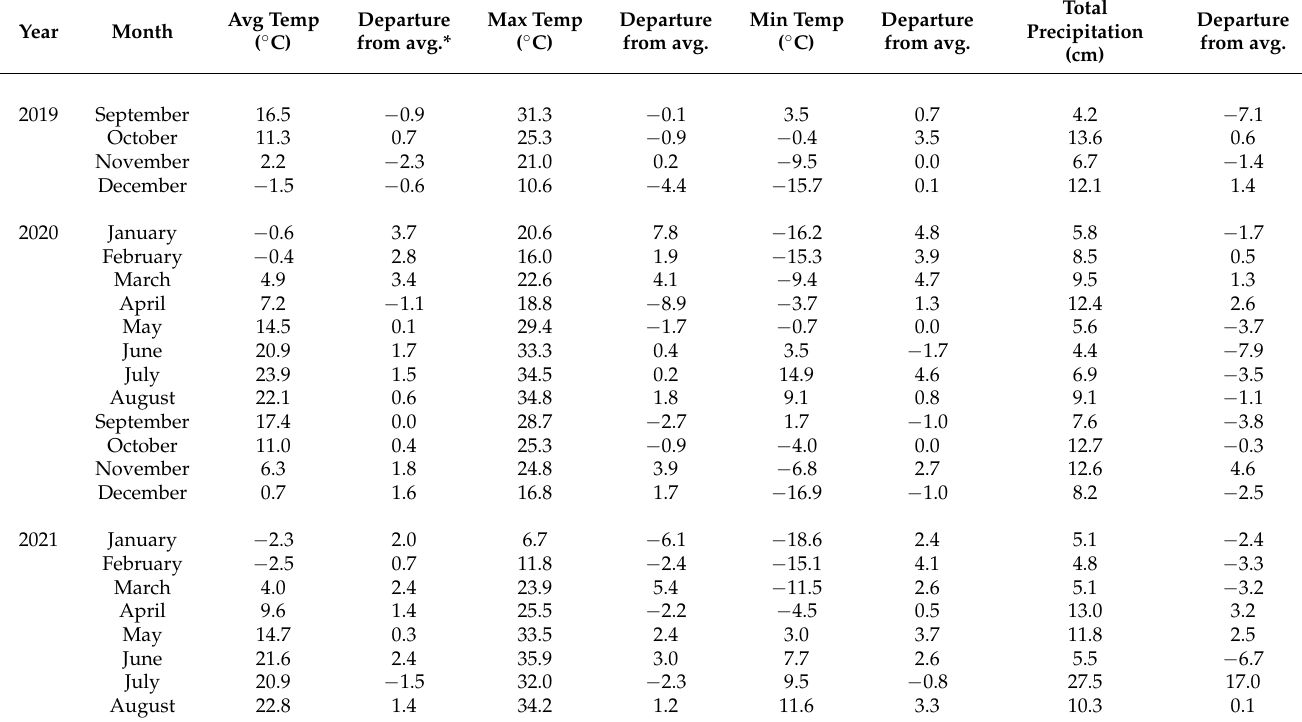
Table 1. Weather Data for the University of Massachusetts Agricultural Research Farm, South Deerfield,